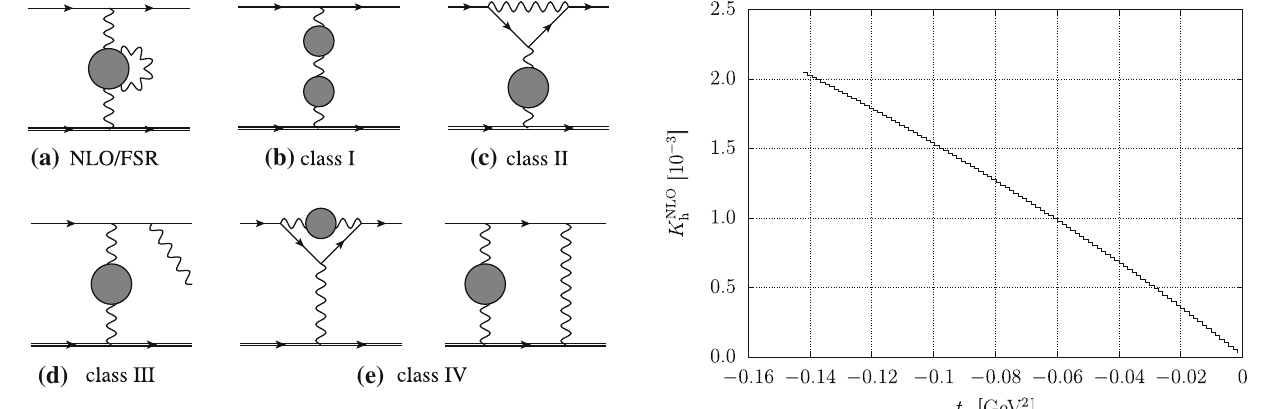
Fig. 9 a Diagramcontributingtothehadroniccorrectionto μ - e scatter- ing at NLO. b – e Examples of diagrams contributing to the four classes of hadronic corrections at NNLO. Electrons, muons and photons are depicted with thin, thick and wavy lines, respectively. The grey blobs indicate hadronic vacuum polarisation insertions (cid:14) μ ¯ ψ( ( x ) = Q f x )γ μ ψ( x ) is the electromag- where j em f